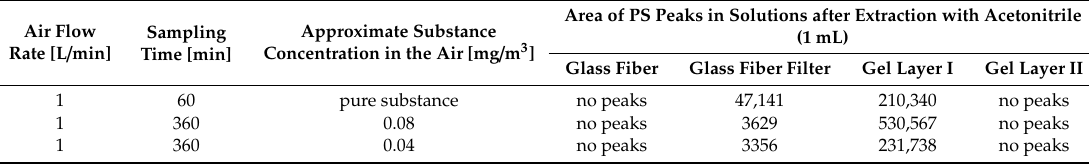
Table 2. Results of PS adsorption on glass fiber, glass fiber filter, and silica gel (SKC glass tubes). GC ‐ MS, HP ‐ 5MS column, programmable column temperature.